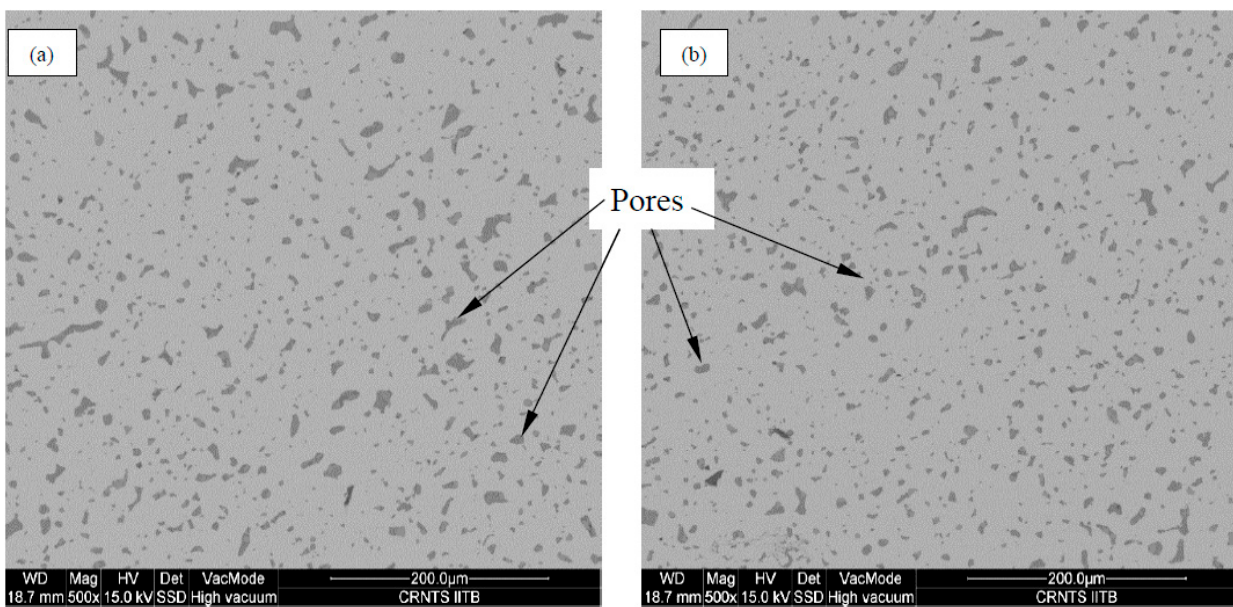
Figure 9. Scanning electron micrograph of the polished surface of sintered samples. Pores in image ( a ) sample from Experiment 22 are larger and more unevenly distributed than in image ( b ) of the sample from Experiment 14. Table 6. Amount of carbon added to iron oxide for carbothermic